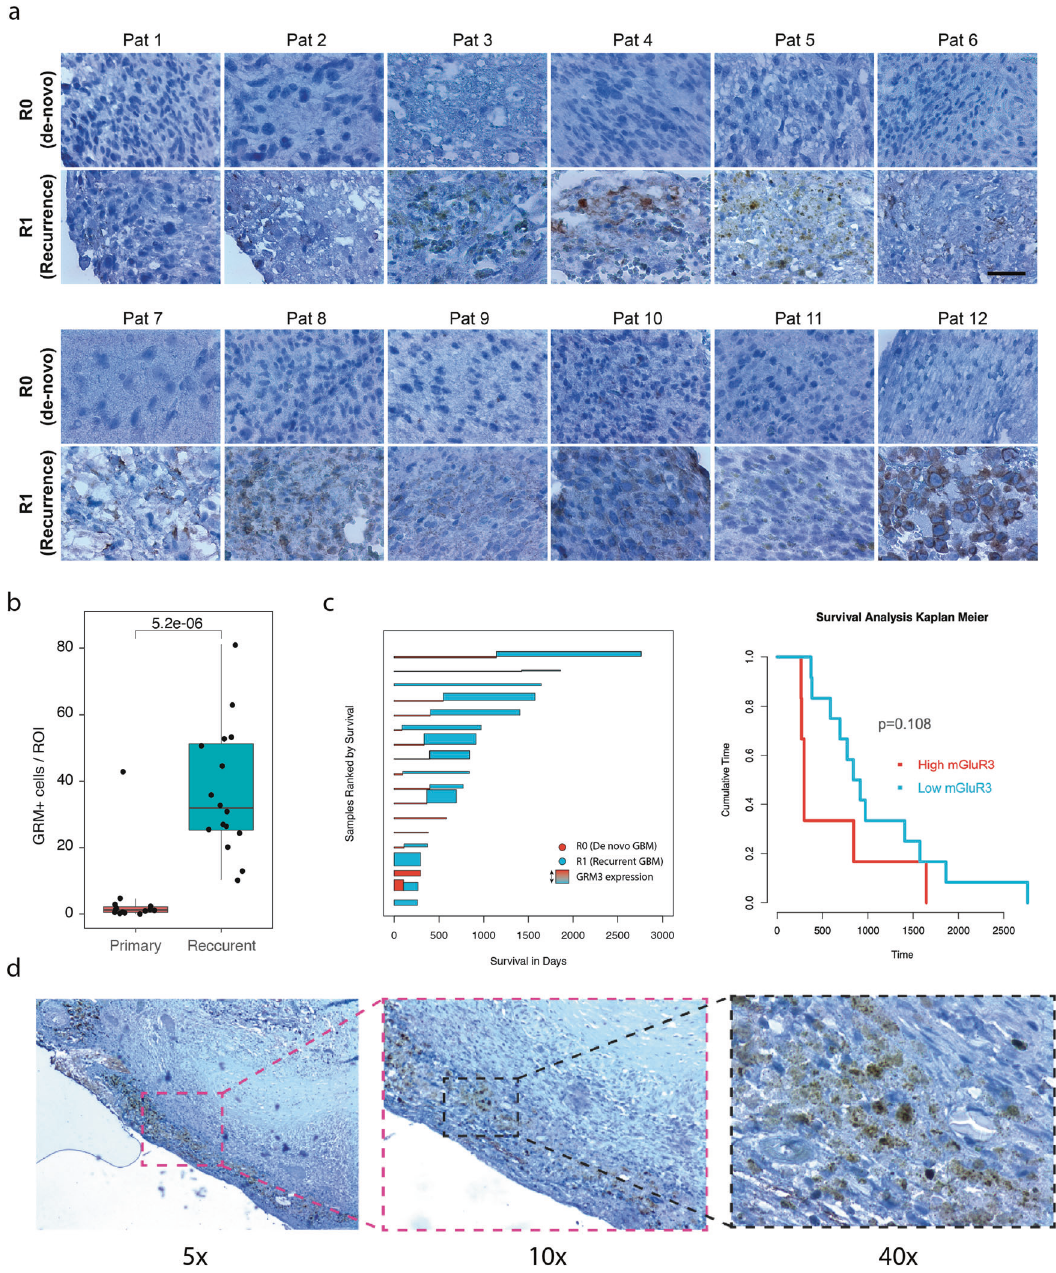
Fig. 3 GRM3 expression in GBM patients. a Patient derived samples show that there is a signi fi cant increase in GRM3 + cells in recurrent patients. b Quanti fi cation of GRM3 + cells within the samples show that there is a signi fi cant increase in the number of cells in the recurrent samples in comparison to de novo samples ( n = 18 patients, 12 paired samples). Scale bar is 50 µm. c Survival analysis from the patient cohort reveals that there is a trend towards increased patient survival when there are fewer GRM3 + cells within the tumor. d Magni fi ed image of a patient sample containing GRM3 + cells. Box plot represents median, with hinges representing 25th and 75th percentile and whiskers representing 1.5x Interquartile